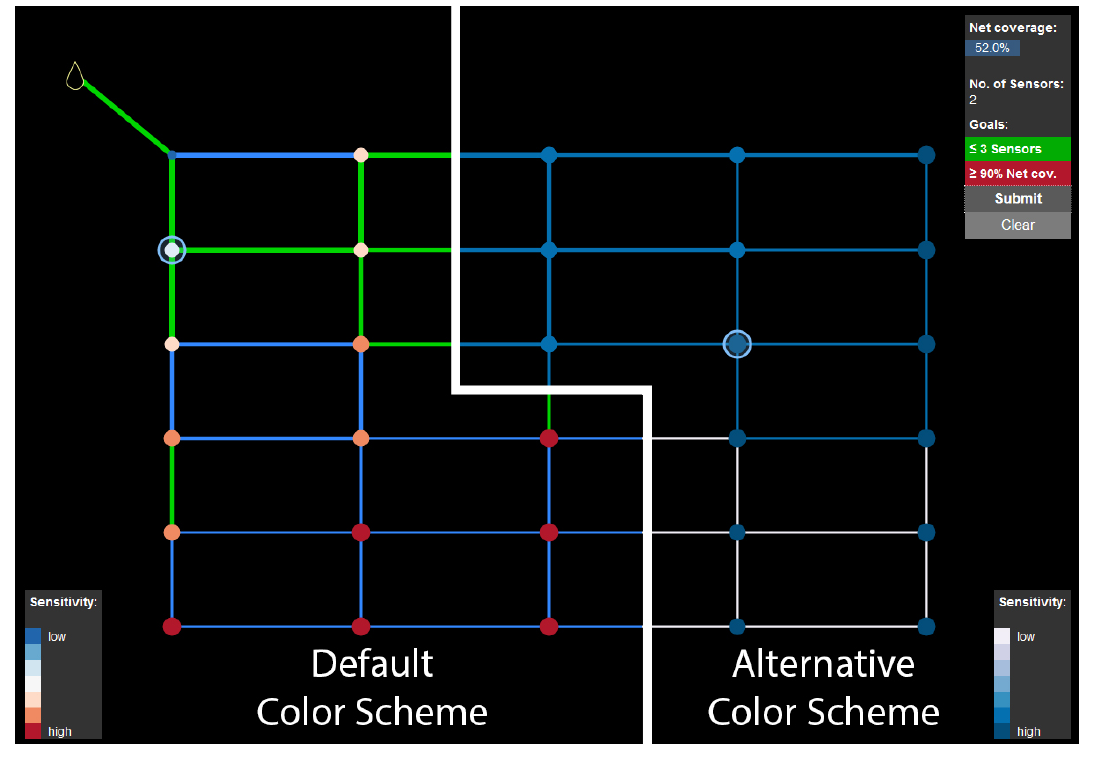
Figure 6. Poulakis model in SSP using ( a ) the default color scheme and ( b ) the alternative color